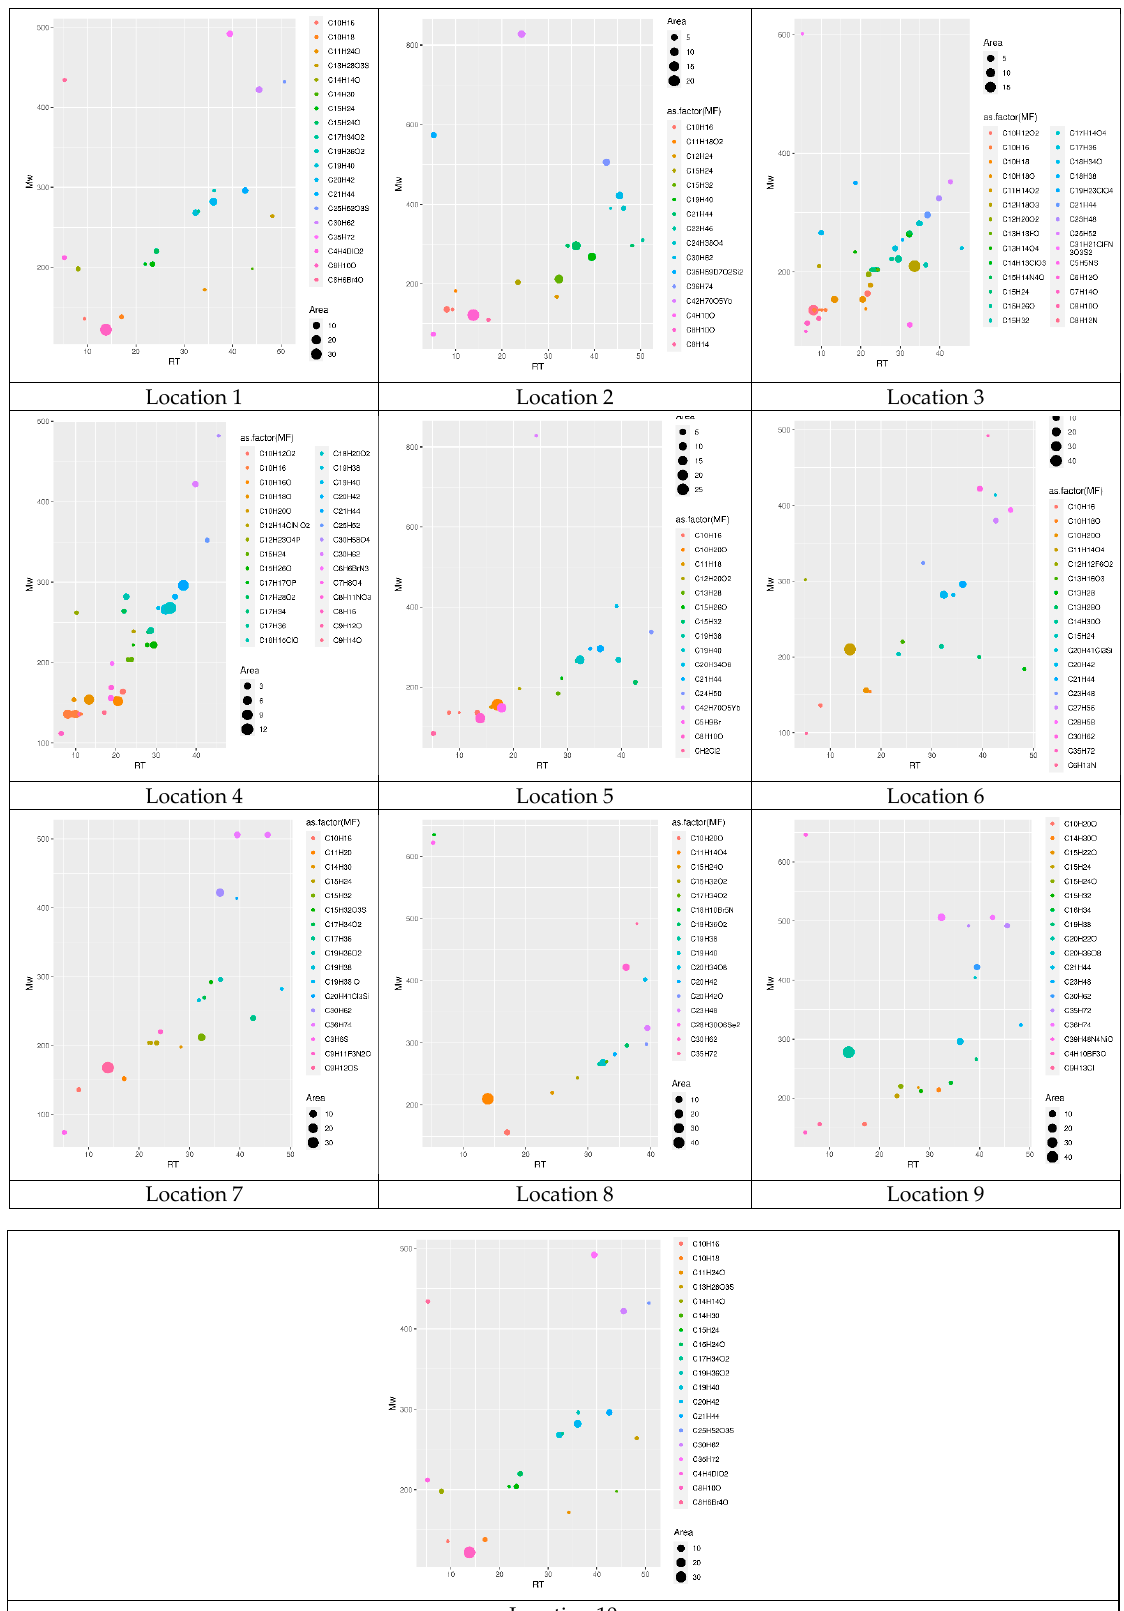
Figure 4. Bubble figures of RT vs. Mw for all of the locations. It is clear that Taif rose accessions are different in their oil composition characteristics. To further quantify the diversity that must be implemented in the proposed model,